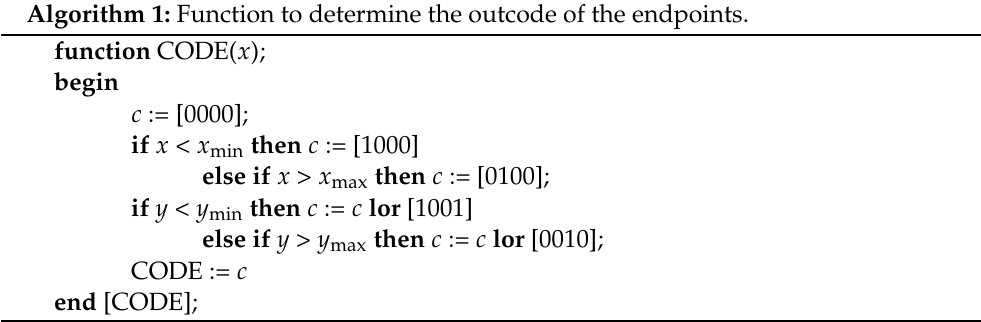
Algorithm 1: Function to determine the outcode of the